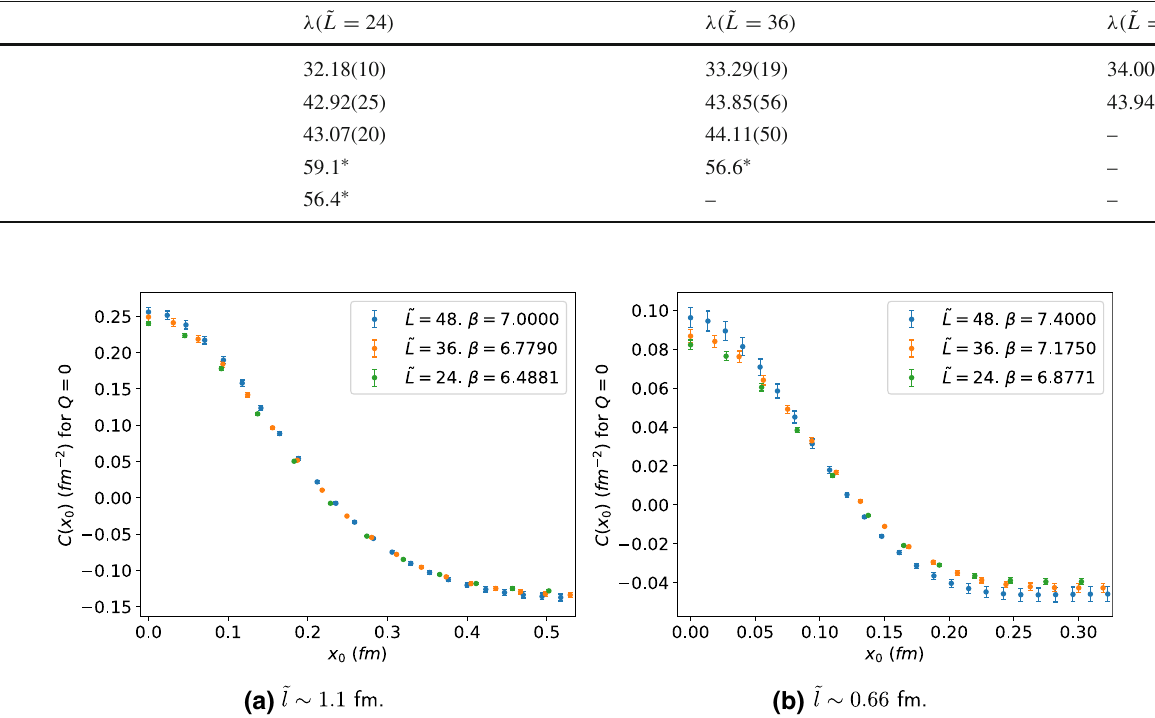
Fig. 8 We display the correlator of topological charge in the trivial topology sector, defined in Eq.